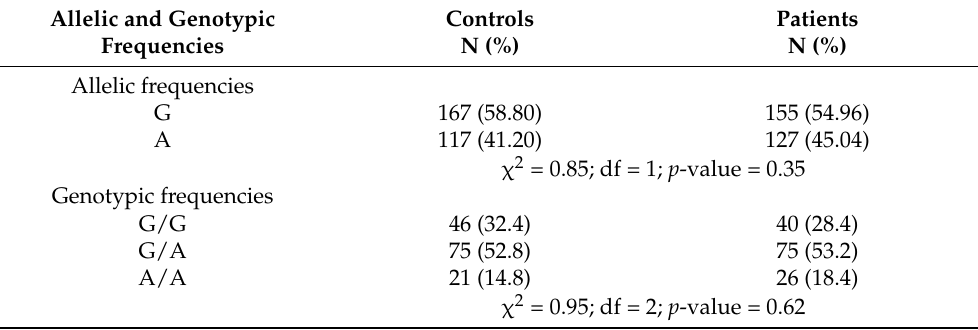
Table 2. COMT allelic and genotypic frequencies in patients with schizophrenia and controls.